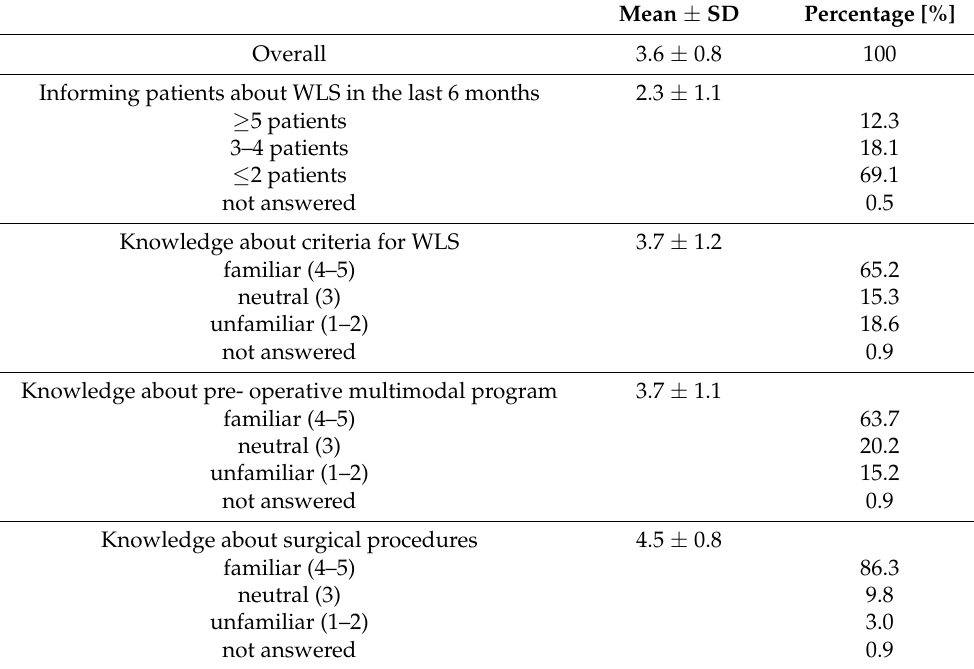
Table 4. Knowledge regarding WLS.